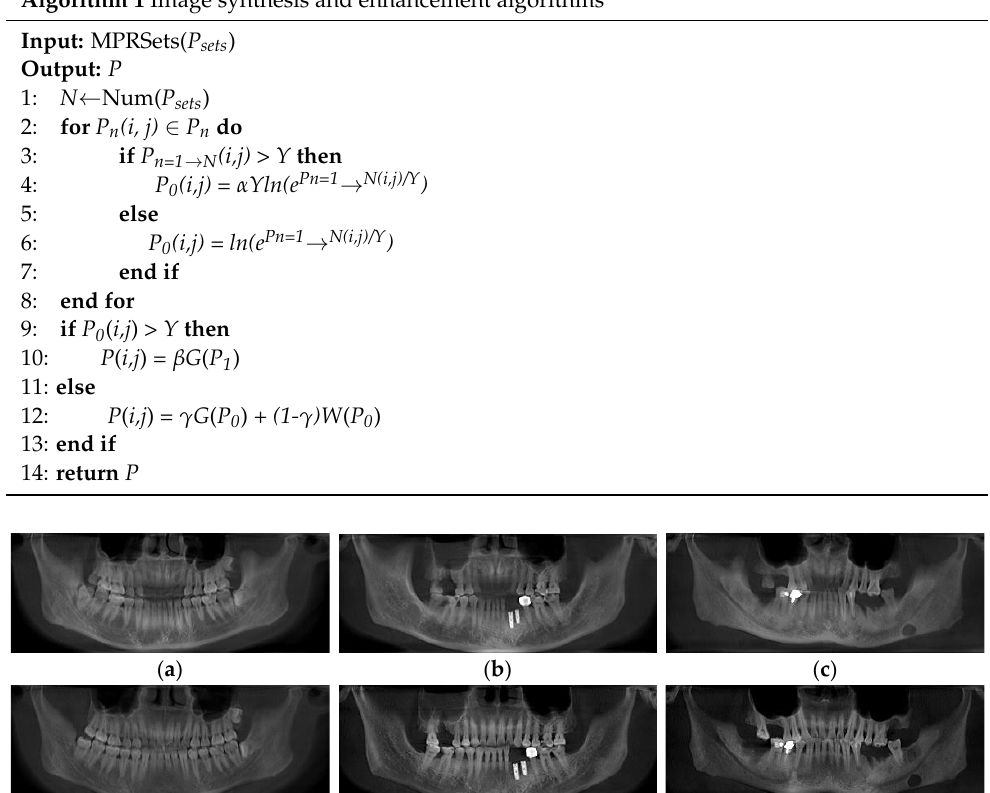
Algorithm 1 Image synthesis and enhancement algorithms